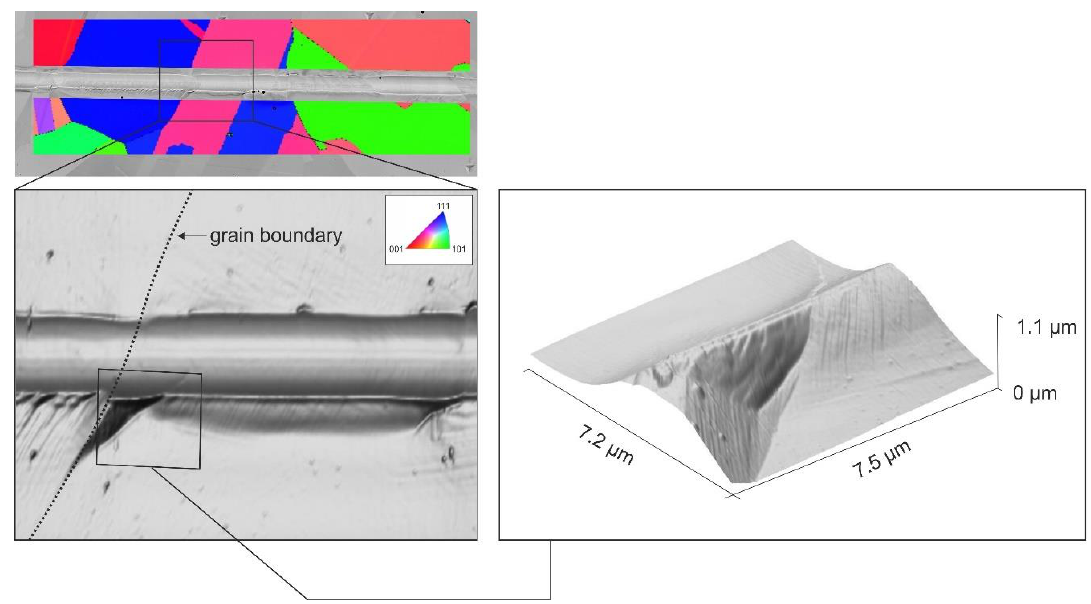
Figure 10. Localized pile-up formation at a grain boundary caused by scratching the polycrystalline microstructure of the LMD specimen (EBSD/BSE image and AFM 3D topography images).